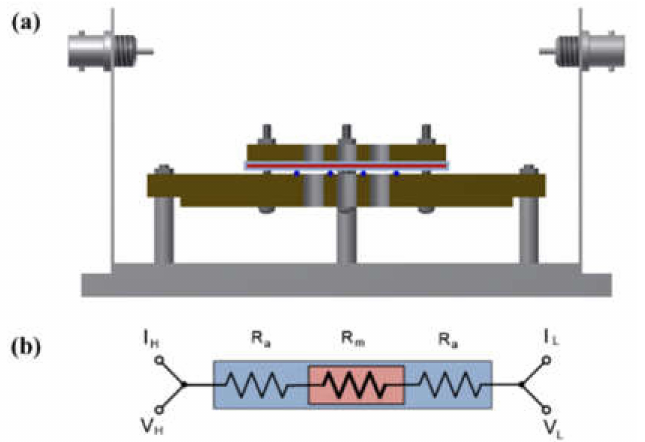
Figure 4. ( a ) Modified four-probe cell and ( b ) electric circuit: the cell without immersing in a KOH solution only installed a wetting membrane. (V H : voltage high; V L : voltage low; I H : current high; IL: current low; R a : ohmic resistance of an alkaline solution; R m : ohmic resistance of a membrane coupon; Ed: electrode to electrode